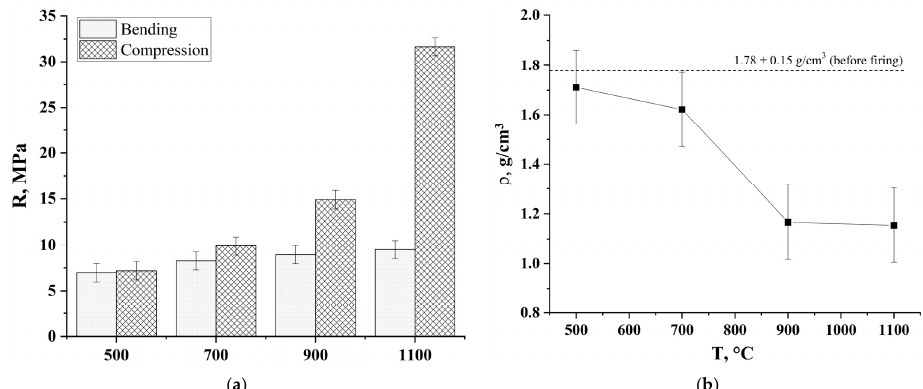
Figure 6. Compressive and bending strengths of the ceramics obtained from pre-ceramic samples based on the hydroxyapatite powder and the aqueous solution of sodium silicate ( a ) and apparent density of ceramics ( b ) after heat treatment at 500, 700, 900 and 1100